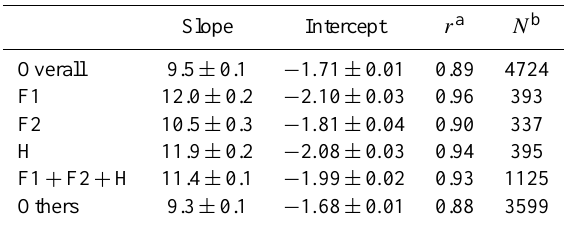
Table 2. Fitted parameters of the plot (Fig. 4) of OS c versus f 44 in different periods. Slope Intercept r a N b